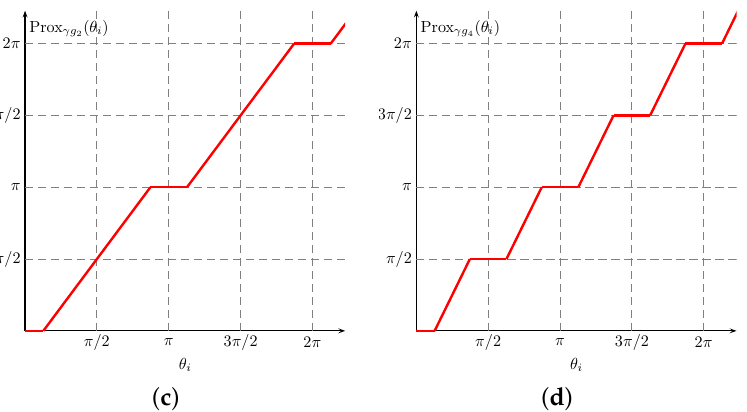
Figure 2. Example plots for various regularization terms and proximal operators. ( a ) The regular- ization term for q = 2. ( b ) The regularization term for q = 4. ( c ) The proximal operator for q = 2. ( d ) The proximal operator for q =